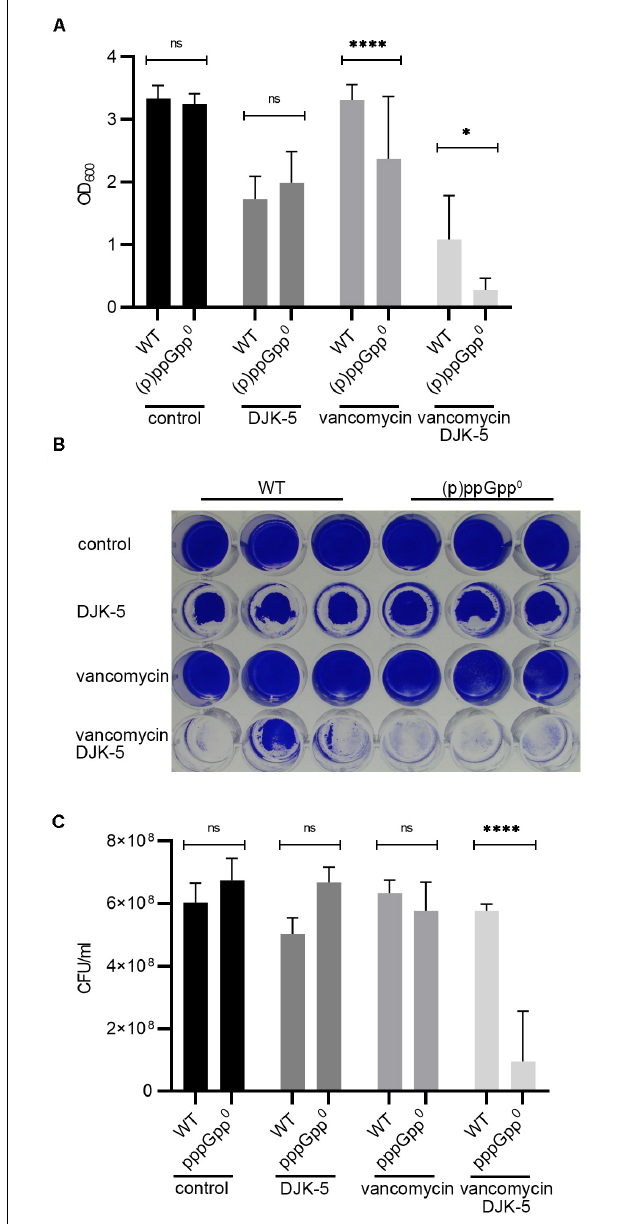
FIGURE 6 | DJK-5 interferes with biofilm formation under relaxed and stringent conditions. (A) Biofilms grown with or without vancomycin (0.78 µ g/ml) and/or the anti-biofilm peptide DJK-5 (5 µ g/ml) in CDM for 24 h. (B) Representative plate stained with crystal violet. (C) CFU of planktonic and biofilm bacteria determined in parallel after static growth for 24 h. Three separate experiments were performed with biological triplicates each. Error bars represent the standard deviation, statistical significance based on ordinary one-way ANOVA (ns: not significant, *: P < 0.1, ****: P <